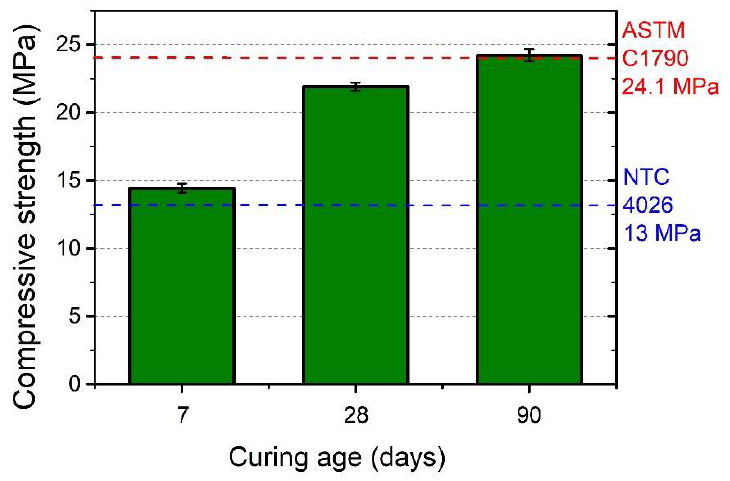
Figure 13. Compressive strength of the hybrid concrete solid blocks. Table 7. Physical properties of the hybrid concrete solid blocks in relation to the specifications established by the standards as high-class structural